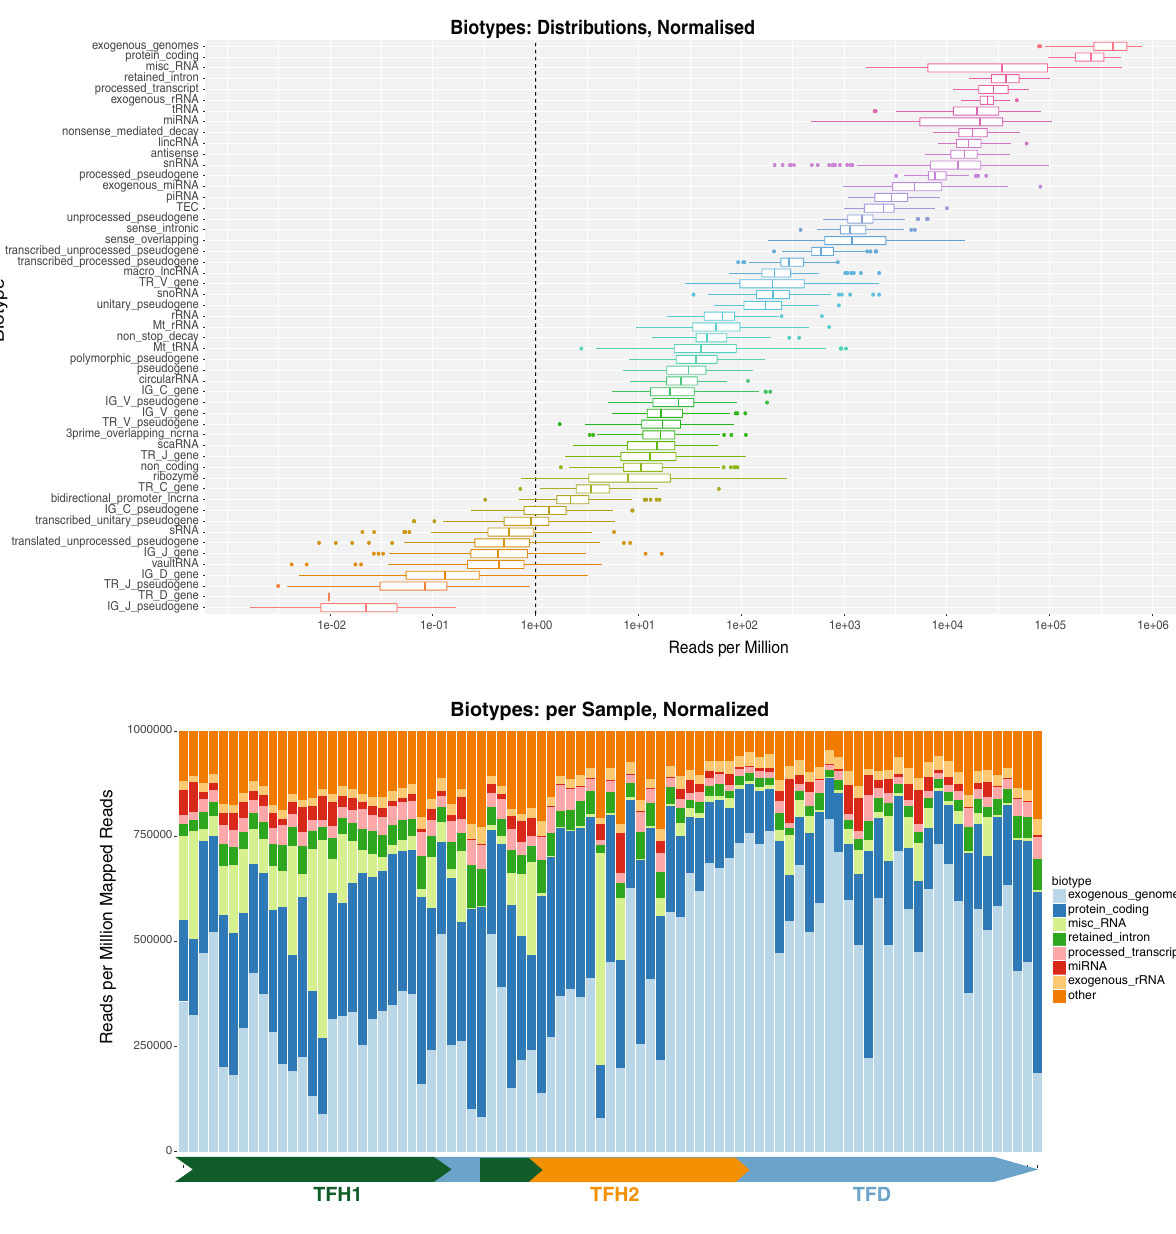
Figure 3. Extracellular vesicle biotypes. ( a ) Various biotypes were detected in EVs, with the overall distributions as shown (results from exceRpt 40 mapped small-RNA-seq from saliva, ∼ 7 to 20 M reads/sample, 50 bp/read). ( b ) The distributions of hourly and daily samples showed variability, particularly in the reduced exogenous genome content in the hourly